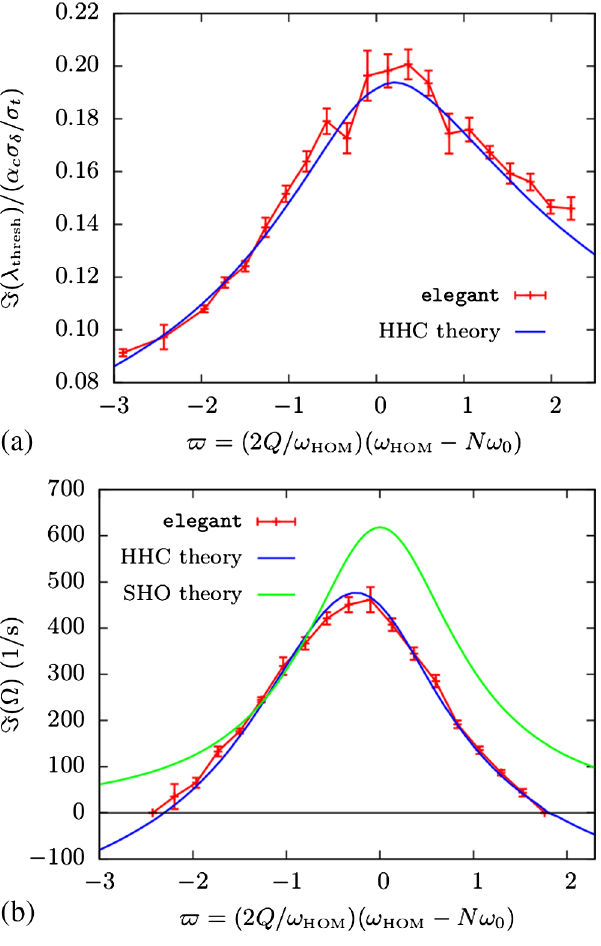
FIG. 2. Comparison of theory (blue) to ELEGANT simulations (red) of the predicted and observed multi-bunch growth rate for no synchrotron radiation damping and longitudinal potential V ∝ z 4 . Panel (a) illustrates the effective Landau damping by 0 plotting the threshold matrix growth rate as a function of normalized HOM detuning; the Landau damping rate is ∼ ð α σ = σ = 10 ∼ h f c δ t Þ s i . Panel (b) plots the simulated and theo- retical growth rate for the 921 MHz HOM in Table I, and compares them to the theory of a simple harmonic oscillator (SHO) of same bunch duration σ t ≈ 51 ps.